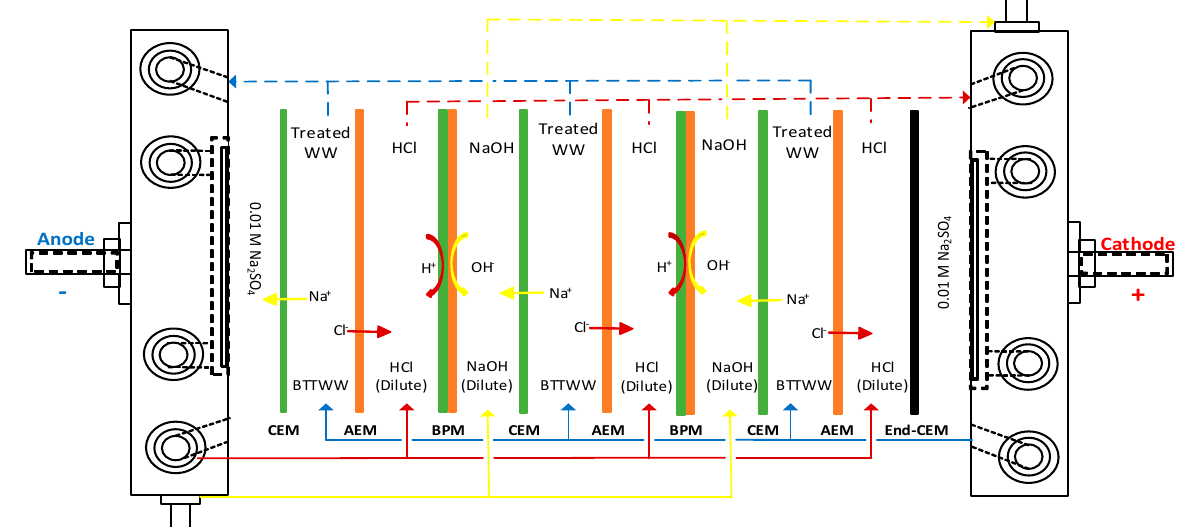
Figure 2. Schematic illustration of BPMED cell operation (CEM: cation exchange membrane, AEM: anion exchange membrane, BPM: bipolar membrane, WW: wastewater).